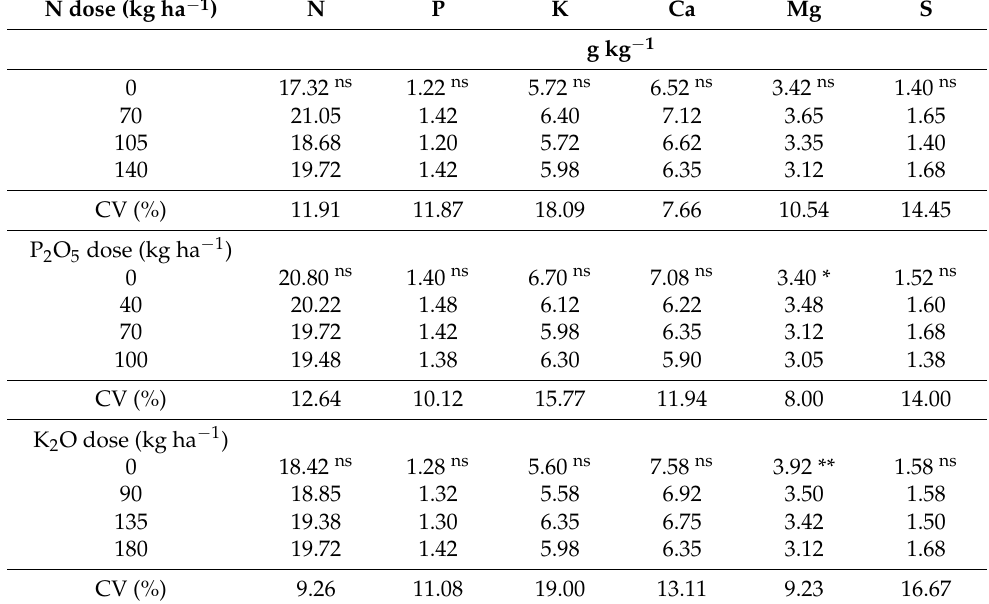
Table 5. Macronutrient analysis in the leaves of eucalyptus at five months after shoot sprouting as a function of residual doses of N, P 2 O 5 and K 2